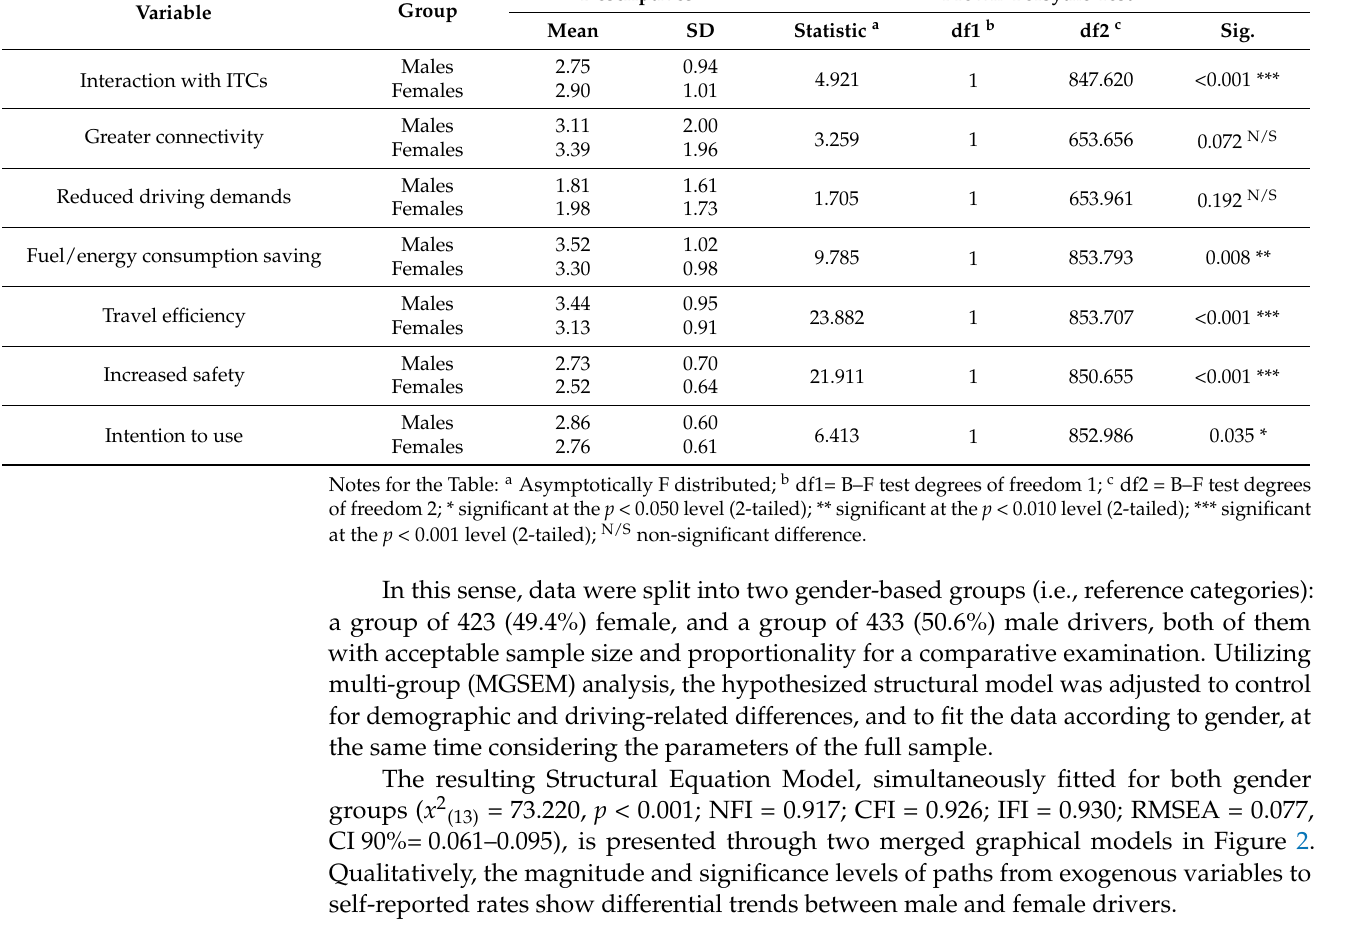
Table 4. Multi-group SEM model to predict drivers’ intention to use automated